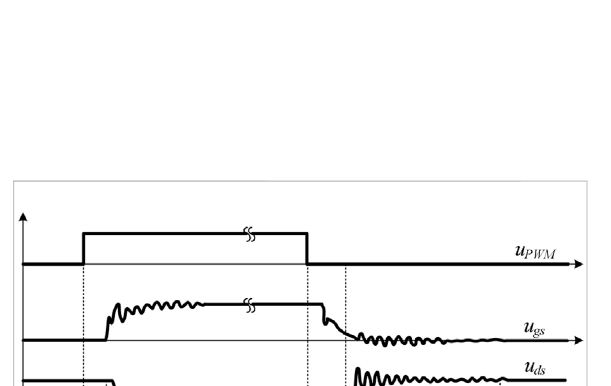
FIGURE 1 Double pulse test setting.